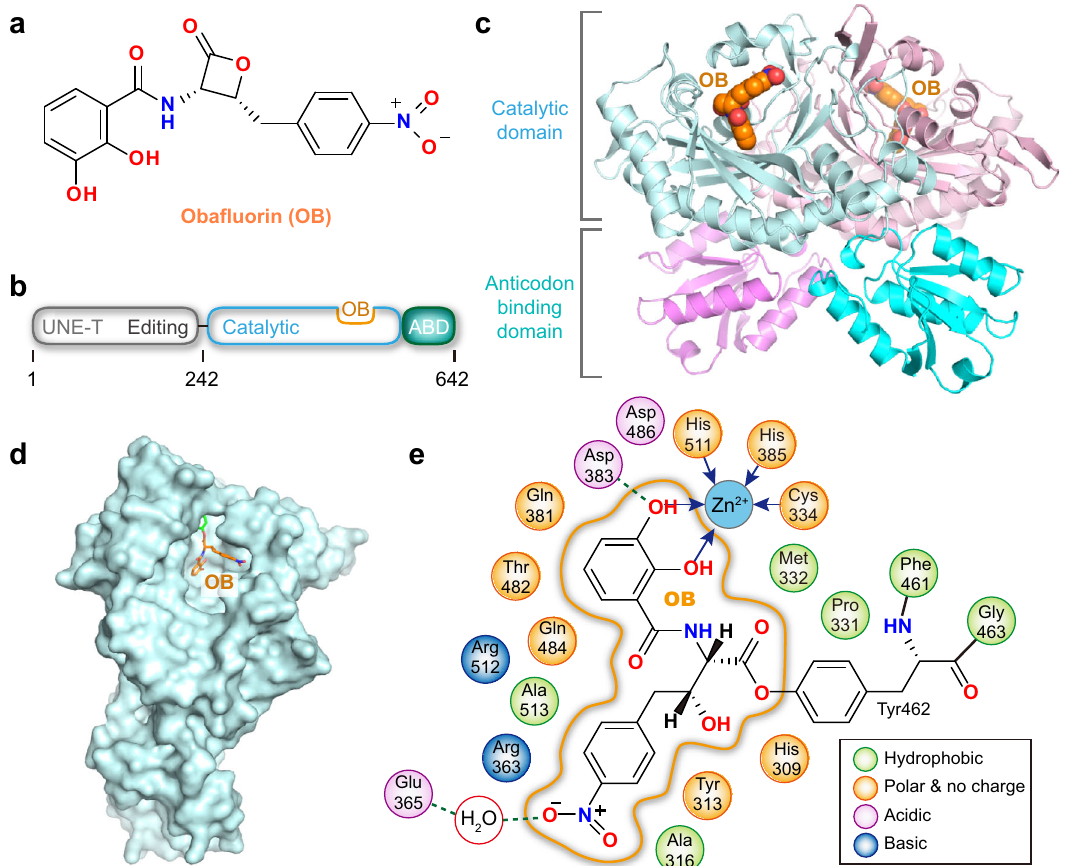
Fig. 1 Structure of E. coli ThrRS bound to Oba fl uorin (OB). a Chemical structure of OB. b Schematic representation of the domain organization of E. coli ThrRS. ABD anticodon-binding domain. c Two ThrRS monomers form an asymmetric unit that is a homodimer. OB is shown as spherical models at the active site of both subunits. d OB (orange sticks) is bound at the center of the ThrRS active pocket (light cyan surface). e Two-dimensional presentation of the OB binding site. Residue Tyr462 is covalently linked to OB through an ester bond. Coordination bonds are shown as blue arrows. H-bonds are shown as green dashed